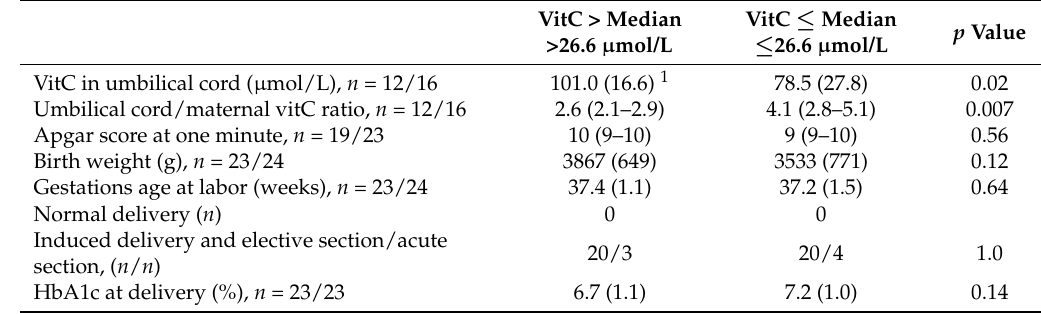
Table 2. Labor and fetus related features in relation to above or below the median level of maternal vitC in late pregnancy.